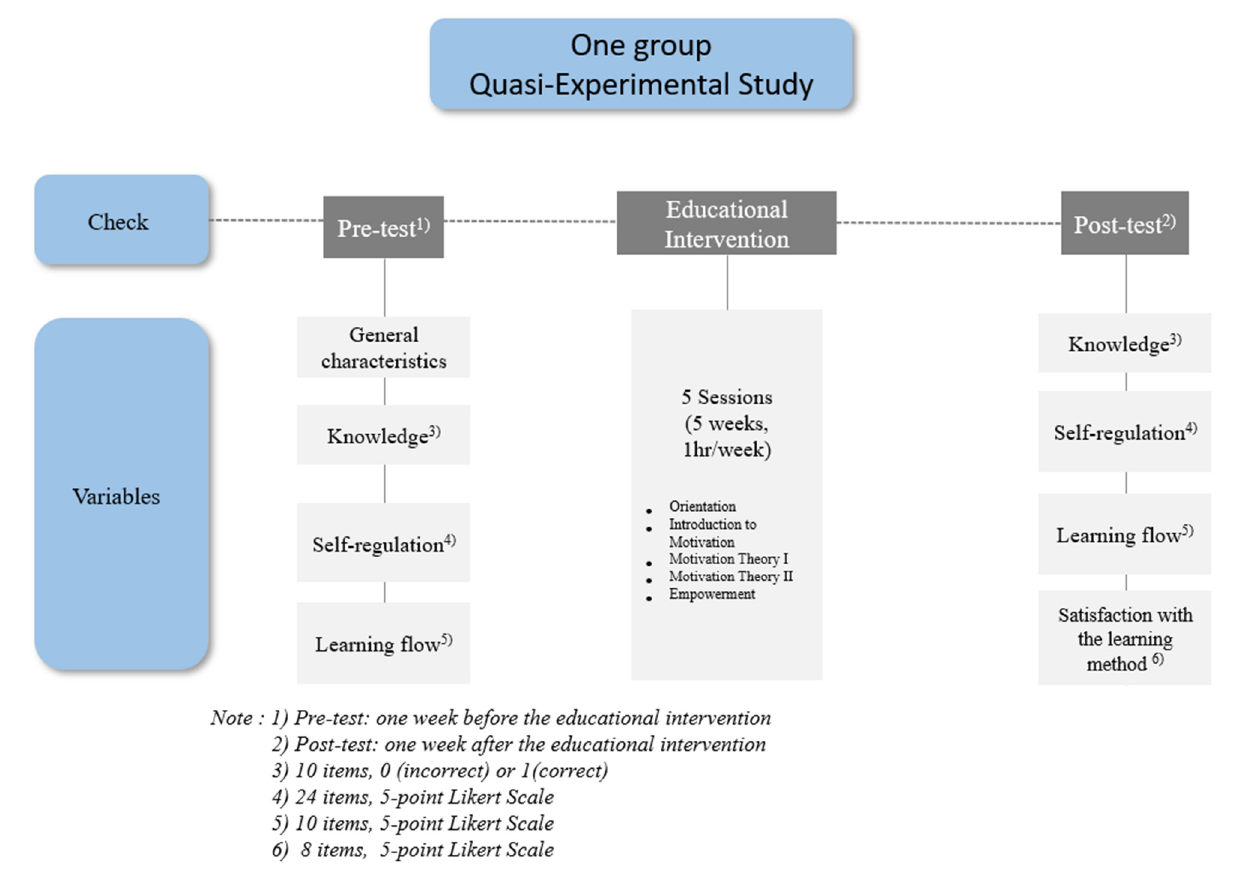
Figure 1. Study design.